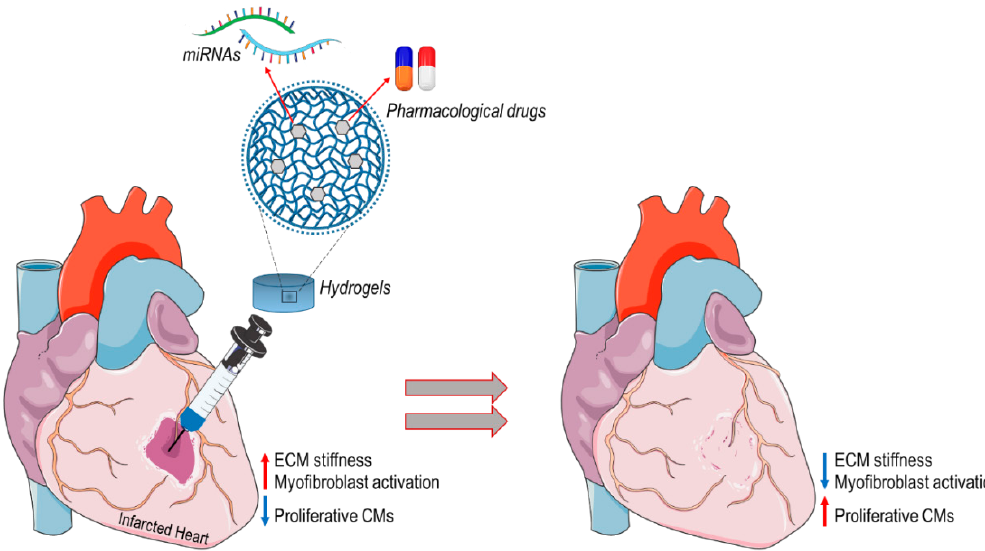
Figure 1. An example of “intelligent hydrogel” application for treating myocardial infarction. Hydrogels with defined mechanical compliance could be used as cell-free scaffolds, functionalized with pharmacological drugs or miRNAs decreasing ECM synthesis and cardiac myofibroblast activation (e.g., miR-29, miR-133 or drugs interfering with YAP transcriptional activity) or inducing CM reactivation of cell cycle to promote tissue regeneration (e.g., collagen/elastin cross-linking inhibitors, YAP/HIPPO signaling inhibitors).